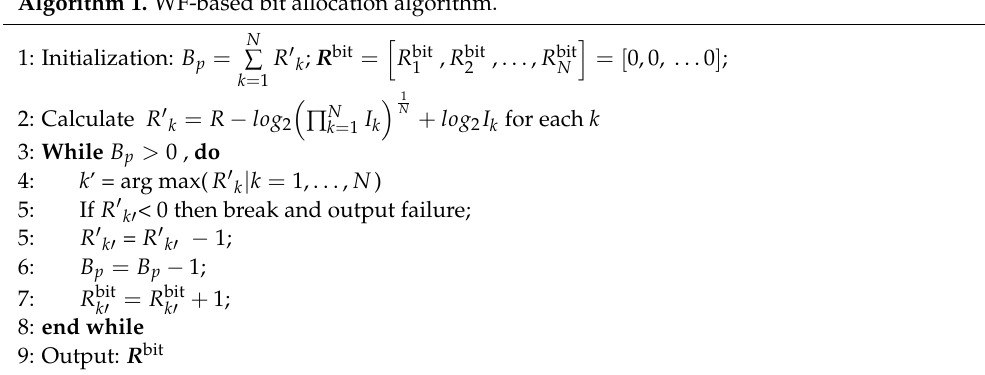
Algorithm 1. WF-based bit allocation